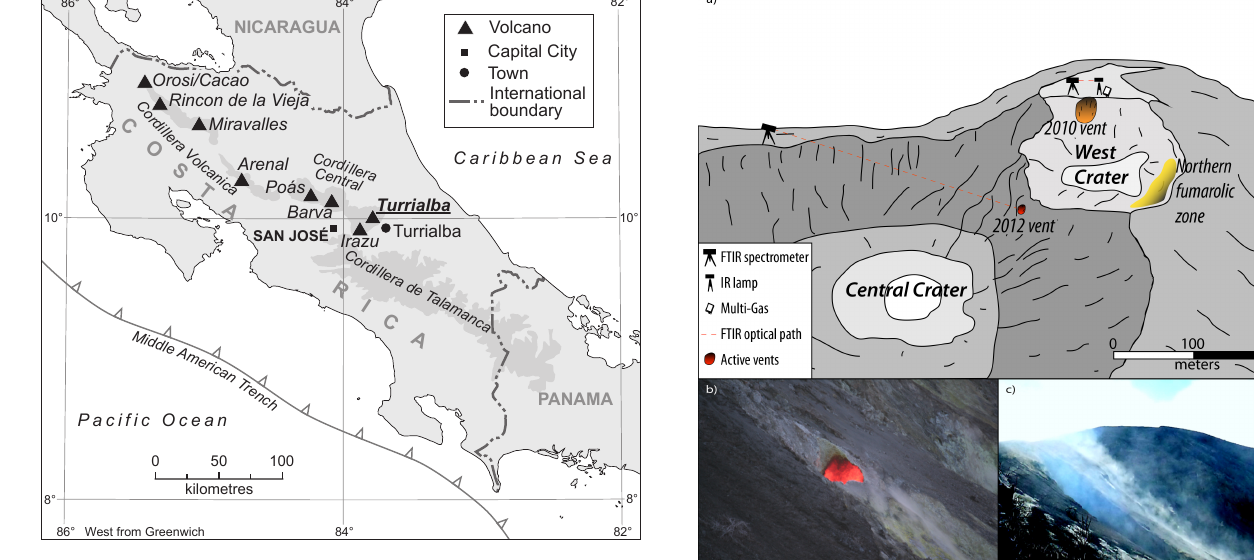
Figure 1. Location map showing Turrialba Volcano at the southern tip of the Cordillera Central volcanic belt. Figure 1 Moussallam et al.,